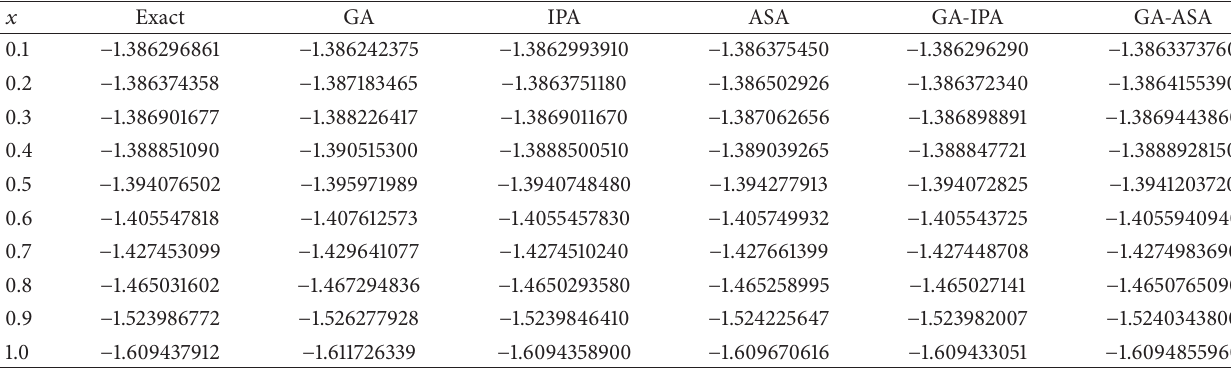
Table 12: Approximate numerical results of Example 3 (for 𝑚 = 0.75 ) by the proposed